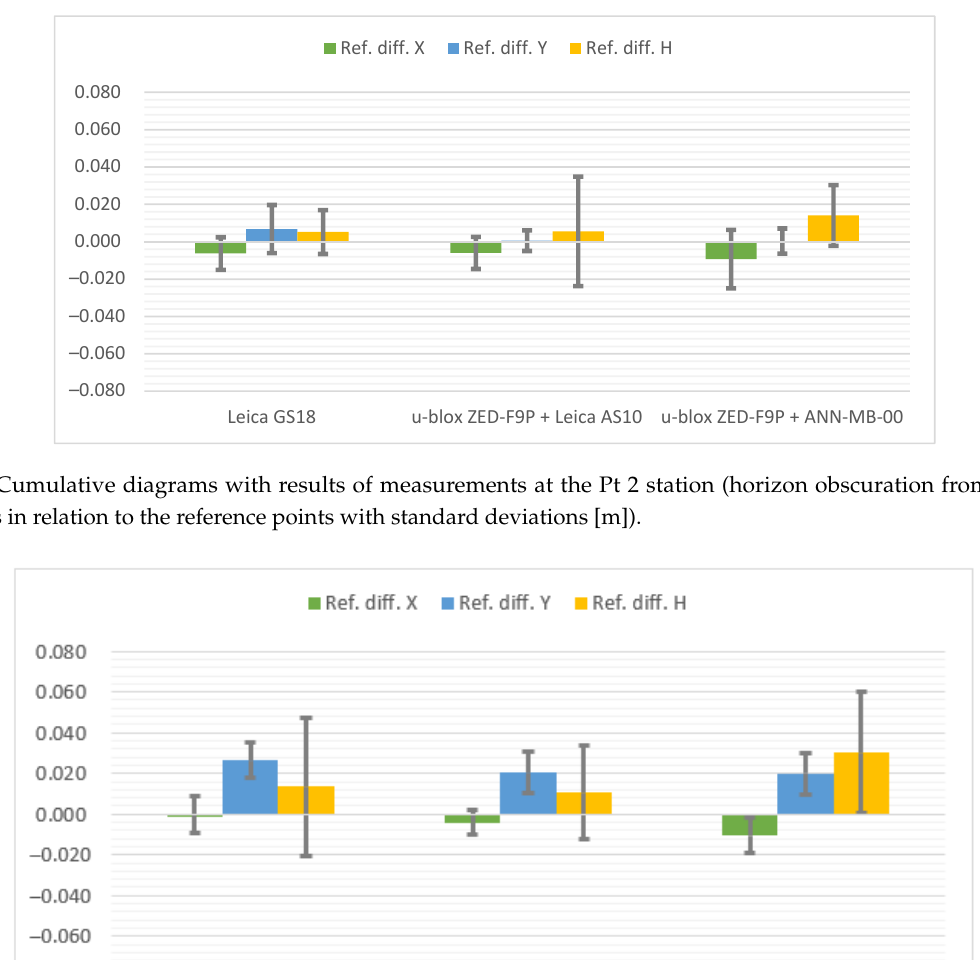
Figure 8. Cumulative diagrams with results of measurements at the Pt 3 station (obscuring the horizon from the east; differences in relation to the reference points with standard deviations [m]).